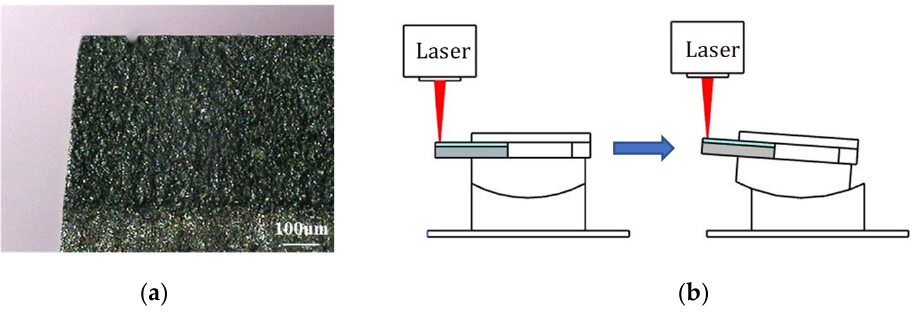
Figure 5. ( a ) Tilted cut edge of the PCD workpiece: ( b ) a single-axis curved stage is installed on the Z-axis positioning stage with a defined tilt angle to offset the cut edge of the PCD workpiece.